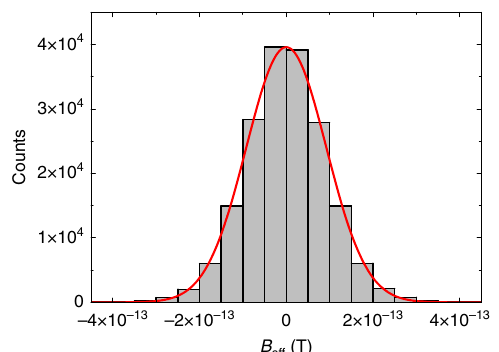
Fig. 4 Histogram of the magnitude of the effective fi eld, B eff . Distribution of B eff is obtained with the weighting computation from data collected for 77 h. The overlaid solid curve represents a fi t with a Gaussian distribution to the data, which gives B eff = (0.94 ± 2.15) × 10 − 16 T. The major systematic effects are below the statistical sensitivity of 2.15× 10 − 16 T